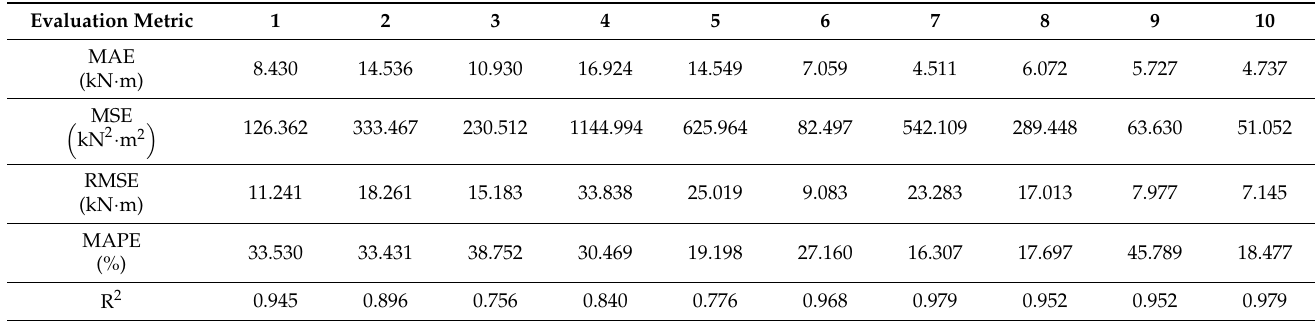
Table 4. Results of 10-fold cross-validation in BP neural